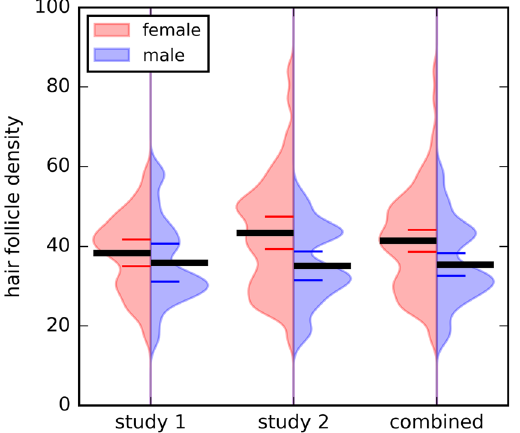
Figure 1. Hair follicle density of the forearm compared between men and women in study 1, study 2, and the combined sample. There was no significant difference in HFD between men and women in study 1. Women presented higher HFD on the forearm in study 2 and in the combined sample. However, this difference was explained by women’s smaller body size. On the x-axis the density of the HFD is plotted. The black line represents the statistical mean value, the red and blue lines, respectively, represent 95% confidence intervals.